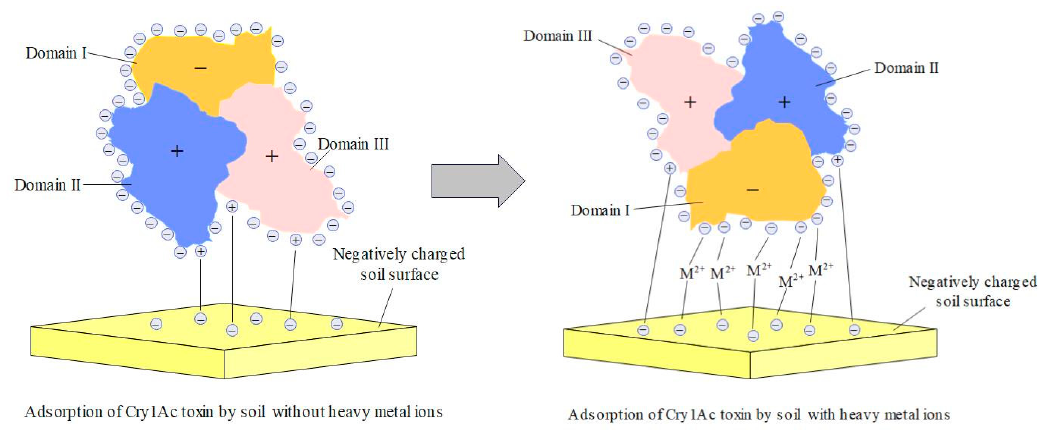
Figure 6. Schematic presentation for the adsorption mechanism between Cry1Ac toxin and soil particles in the presence or absence of heavy metal ions.